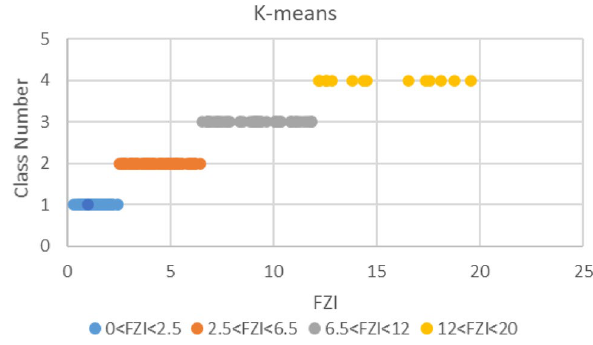
Fig. 11 Reduction in sum square error by increasing the number of clusters